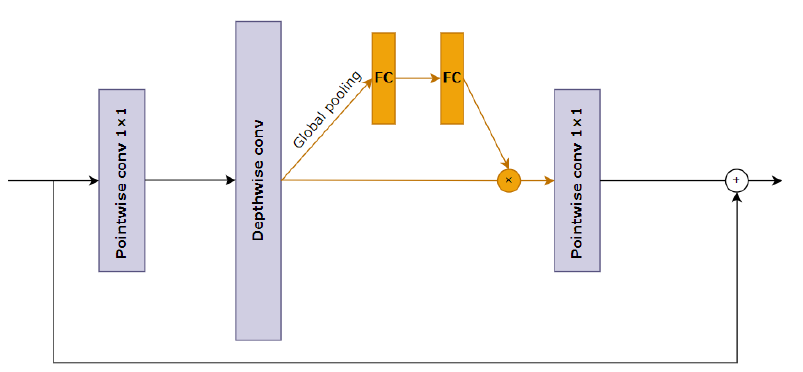
Figure 4. Structure of the MBConv building block, consisting of a depthwise separable convolution with an inverse bottleneck and squeeze-and-excitation